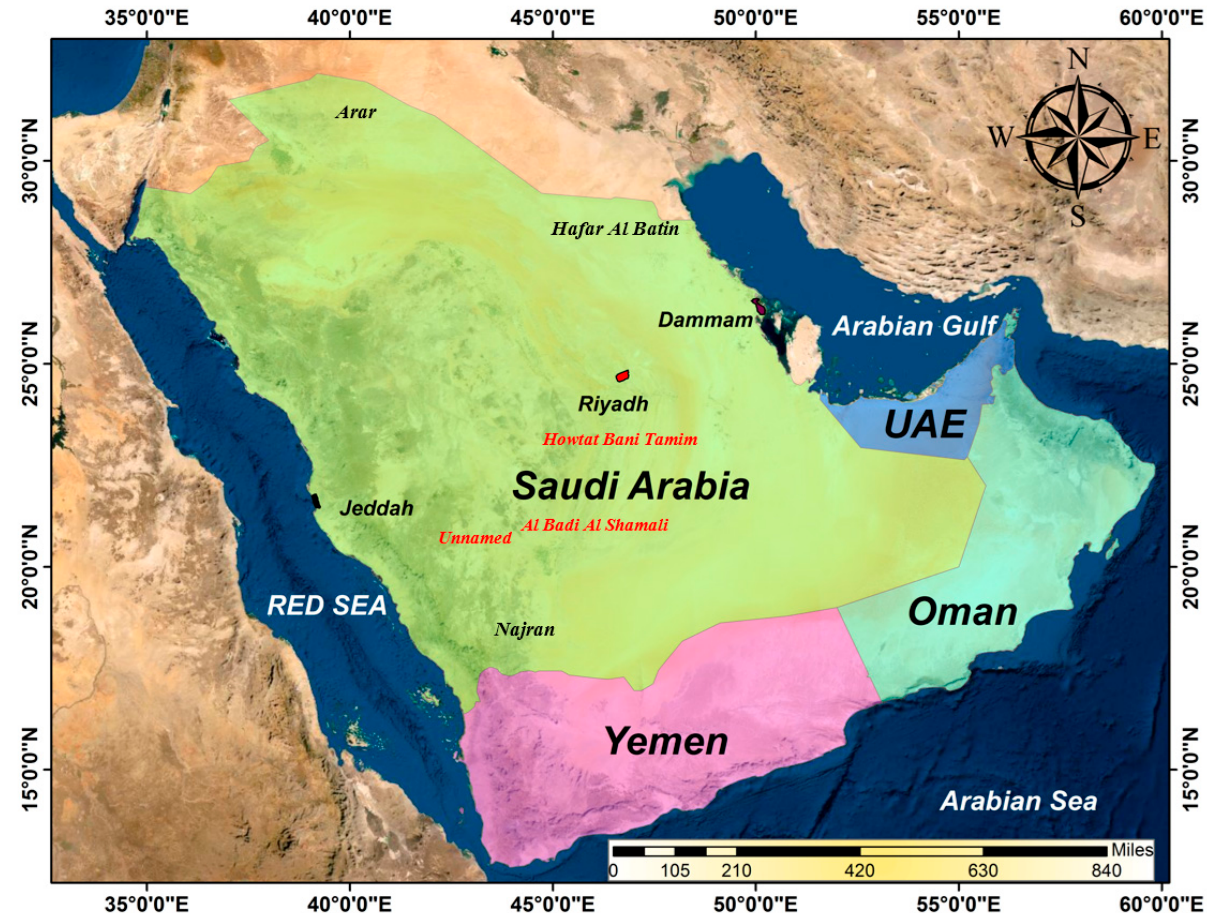
Figure 1. Map of Saudi Arabia and other countries in the Arabian Peninsula.